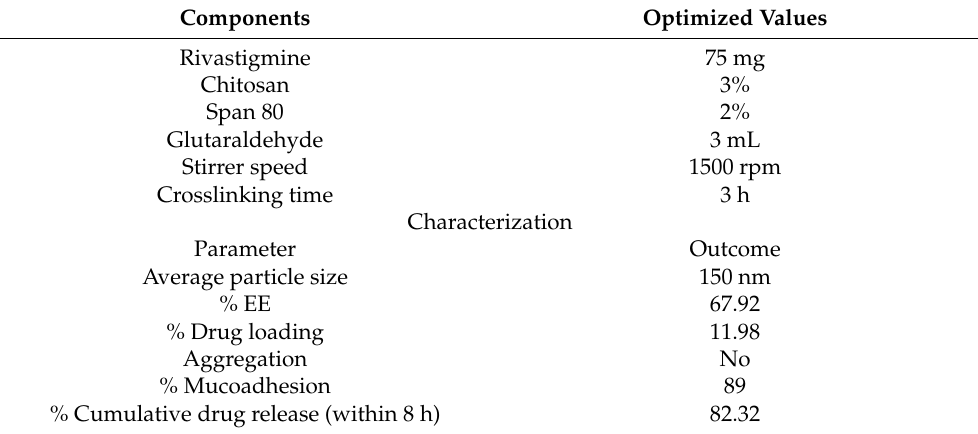
Table 2. Formulation composition and characterization parameters of batch P17 to fabricate nanopar- ticles containing